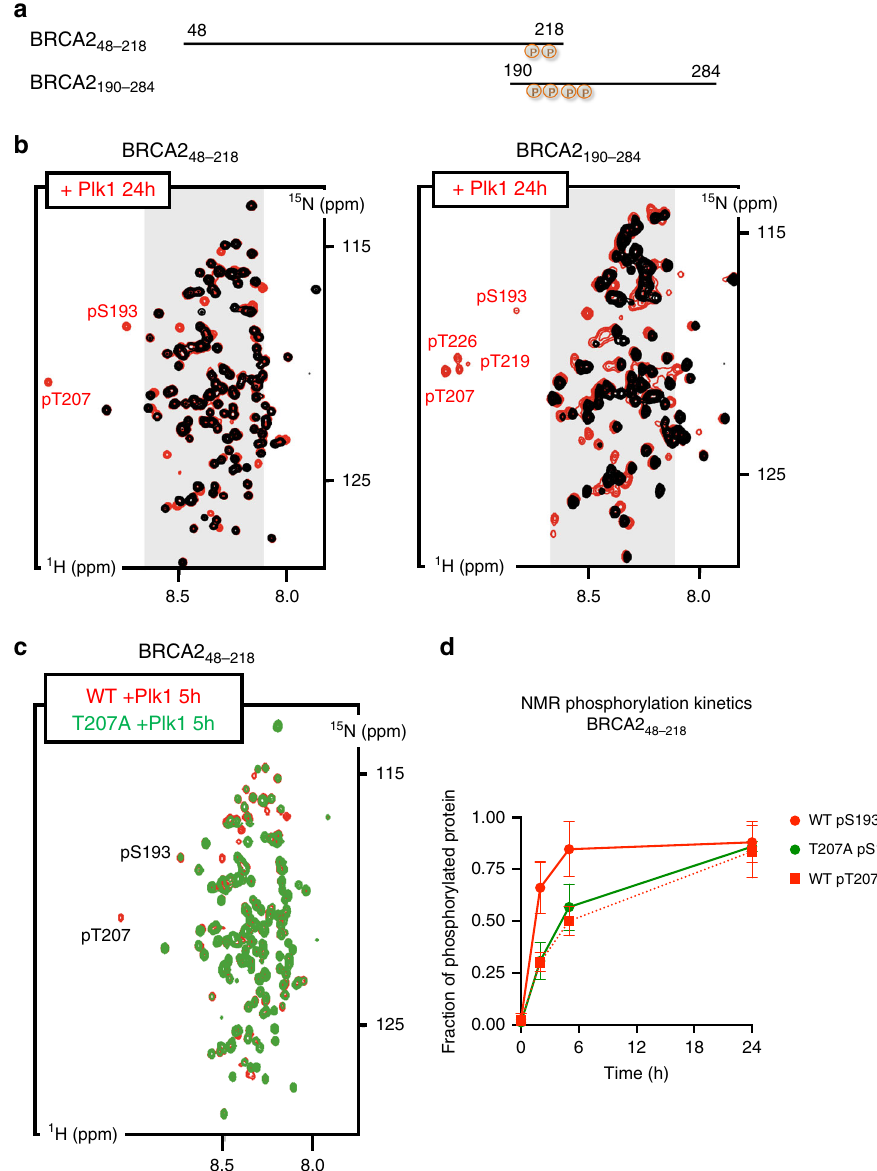
Fig. 2 PLK1 phosphorylates T207 in BRCA2 48 – 218 and BRCA2 190 – 284 . Phosphorylation of BRCA2 48 – 218 and BRCA2 190 – 284 by PLK1 as observed by NMR. a Schematic view of the two overlapping BRCA2 fragments analyzed by NMR. Residues identi fi ed as phosphorylated in ( b ) are indicated. b Superposition of the 1 H- 15 N HSQC spectra recorded before (black) and after (24 h; red) incubation with PLK1. Each spectrum contains one peak per backbone NH group. Most peaks are located in the gray region of the spectrum, indicating that they correspond to disordered residues. Assignment of each peak to a BRCA2 residue was performed using a classical heteronuclear NMR strategy. Peaks corresponding to phosphorylated residues are indicated. c Comparison of the phosphorylation kinetics recorded for BRCA2 48 – 218 WT and T207A. 1 H- 15 N HSQC spectra of BRCA2 48 – 218 WT (red) and T207A (green) recorded 5 h after addition of PLK1 are superimposed to highlight the overall decrease of phosphorylation observed for the mutant compared to the WT. d Fraction of phosphorylated protein deduced from the intensities of the peaks corresponding to the non-phosphorylated and phosphorylated residues plotted as a function of time. WT S193 and T207 timepoints are represented by red circles and squares, respectively, while T207A S193 timepoints are represented by green circles. The graph represents data as mean ± SD from three independent experiments. Source data are available as a Source Data fi